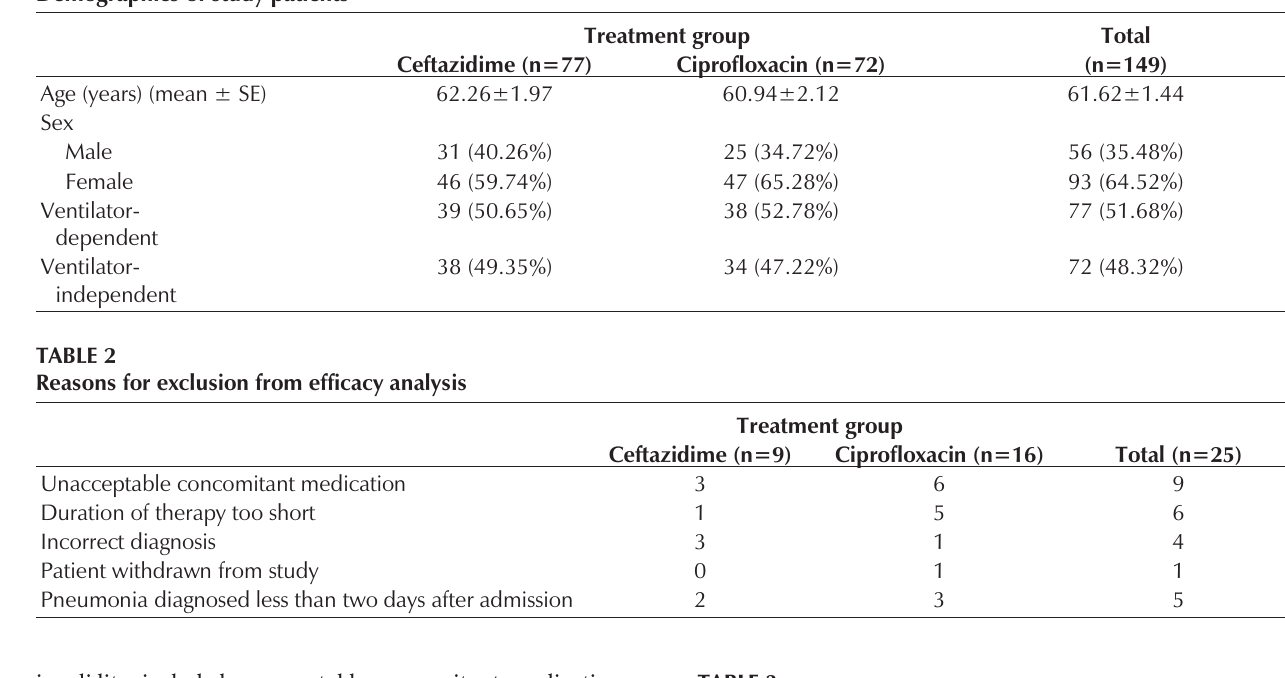
Demographics of study patients